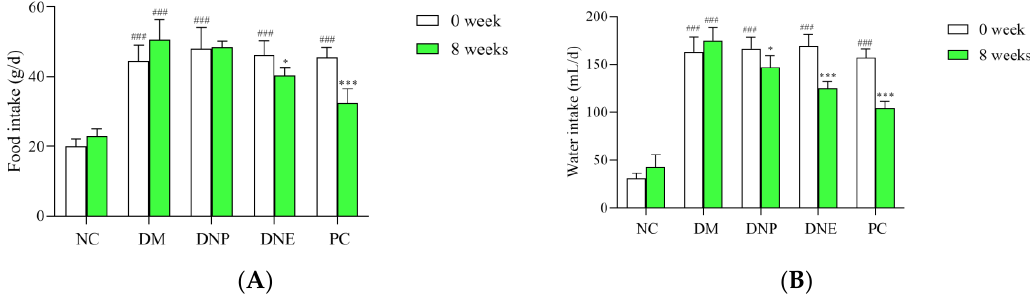
Figure 10. Effects of D. nobile on food intake ( A ) and water intake ( B ) of T2DM rats. All data are expressed as mean ± S.D. (n = 6 per group). Compared with the NC group, ### p < 0.001; compared with the DM group, * p < 0.05 and *** p < 0.001.